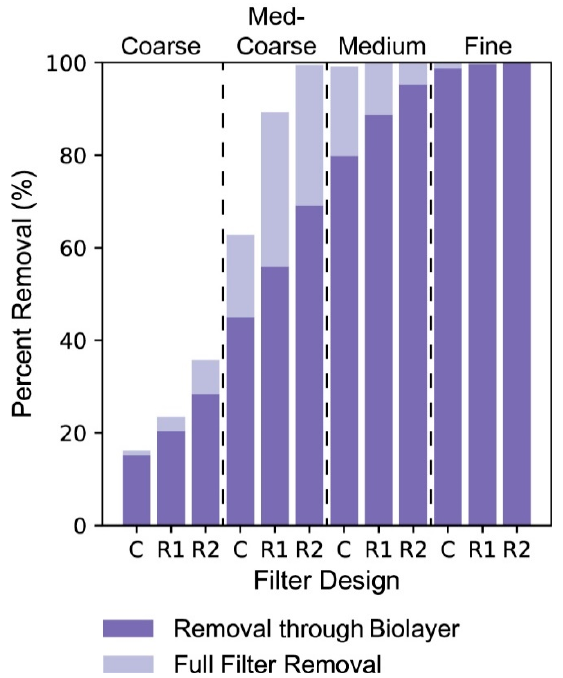
Figure 7. Modeled percent removal of E. coli at the biolayer and at the full filter length for a traditional BSF design (C), a 40% reduced-height design (R1), and a 70% reduced-height design (R2). Results of the contaminant removal modeling (Section 2.5) for MS2 for each BSF design and media condition are displayed in Figure 8.